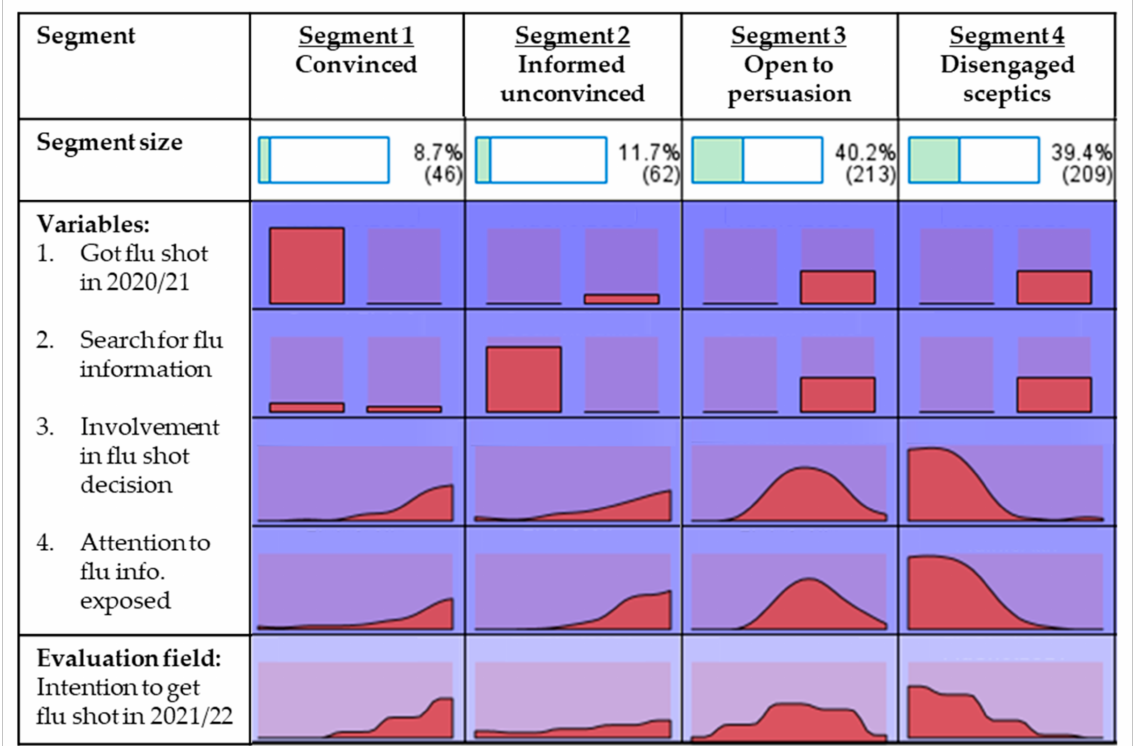
Figure 1. Distribution of segmentation variables by